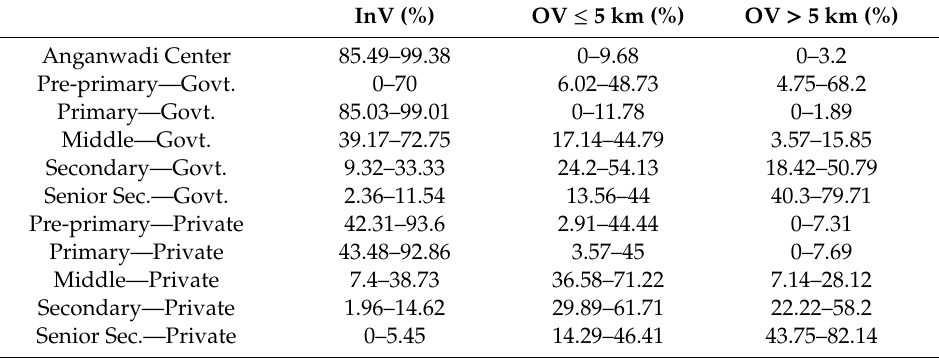
Table 2. The interquartile range for percentage of villages where there is at least 1 education infrastructure in the village (InV%), the nearest education infrastructure is outside the village and within 5 km (OV ≤ 5 km%), and the nearest education infrastructure is outside the village and over 5 km away (OV > 5